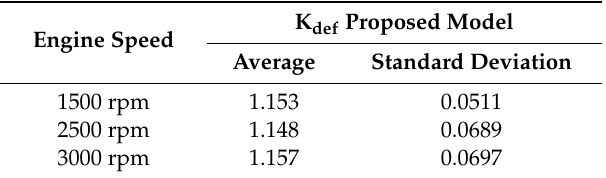
Table 5. Values obtained from the coe ffi cient of deformation K def